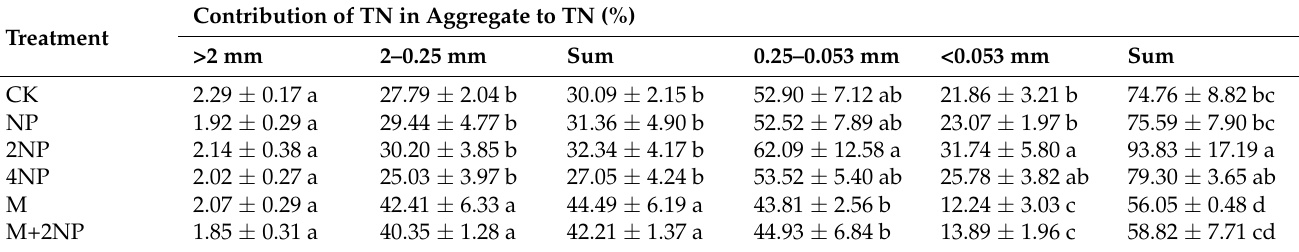
Table 6. Contribution rate of total nitrogen in soil aggregates of different